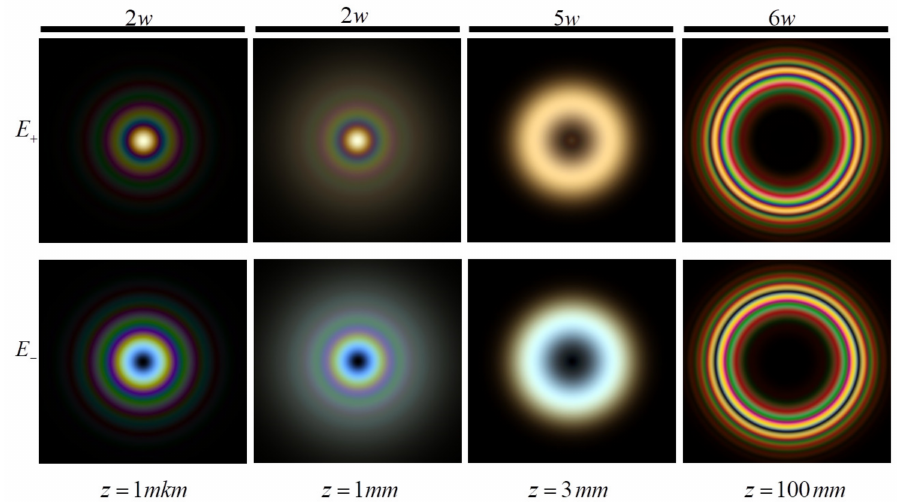
Figure 8. Generation of a Bessel–Gauss beam with l = 2 from a Bessel–Gauss beam with l = 0 in a lithium niobate